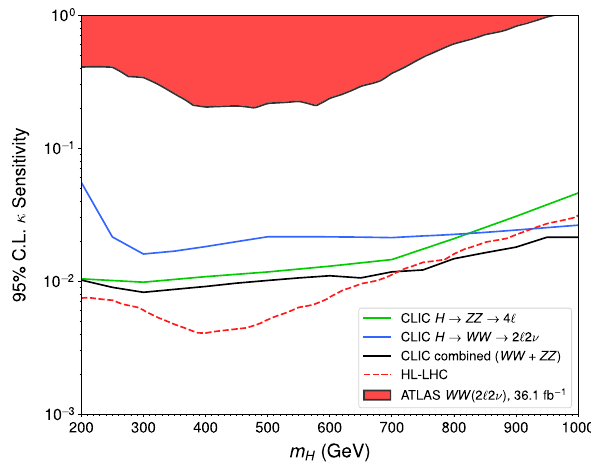
Fig. 7 95% C.L. sensitivity to κ = σ H /σ SM as a function of m H H for e + e − → H νν ( H → WW → 2 (cid:2) 2 ν ) at 3 TeV CLIC with L = 2000fb − 1 (solid blue line), together with the sensitivity for H → Z Z → 4 (cid:2) from Fig. 4 (solid green line) and the combined sensitivity (solid black line). Shown for comparison are the 95% C.L. excluded region from present ATLAS H → WW searches [21] (red region) and the projected HL-LHC (13 TeV, L = 3ab − 1 ) 95% C.L. sensitivity reach (dashed red line), dominated by H → Z Z searches (see Sect.